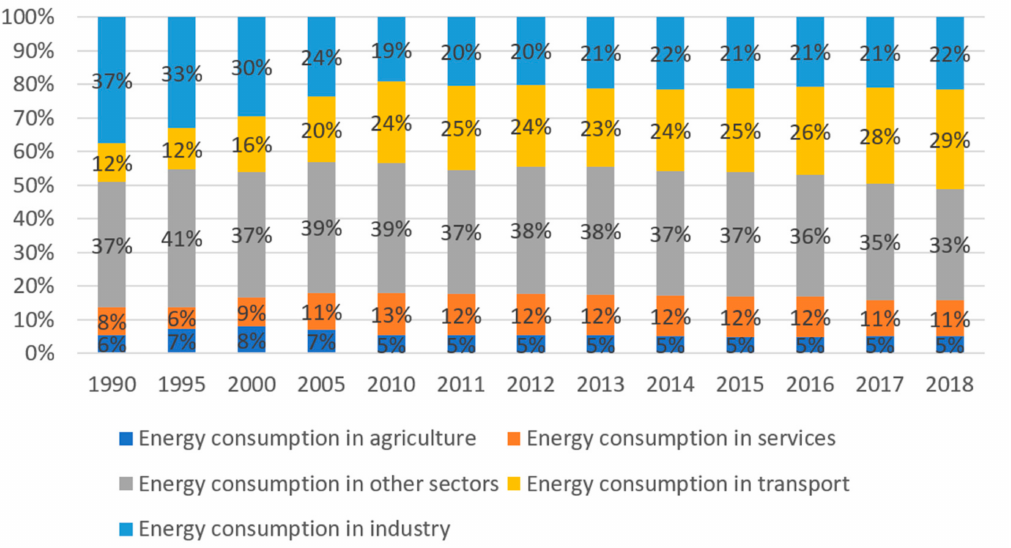
Figure 8. Structure of energy consumption in Poland in 1990–2018. For Slovakia, a higher energy consumption for industry was recorded compared to other Visegrad Group members (33.15% in 2018) (Figure 9). Similarly, the increase in energy absorption in transport was noted in the analysed period (from 9.18% in 1990 to 24.59% in 2018). As for other sectors, after 2010, stable level of energy consumption can be observed (more or less 29%). For the remaining two sectors (services and agriculture), falling trends can be observed: from 23.22% to 11.71% for services and from 4.48% to 1.18 for agriculture.